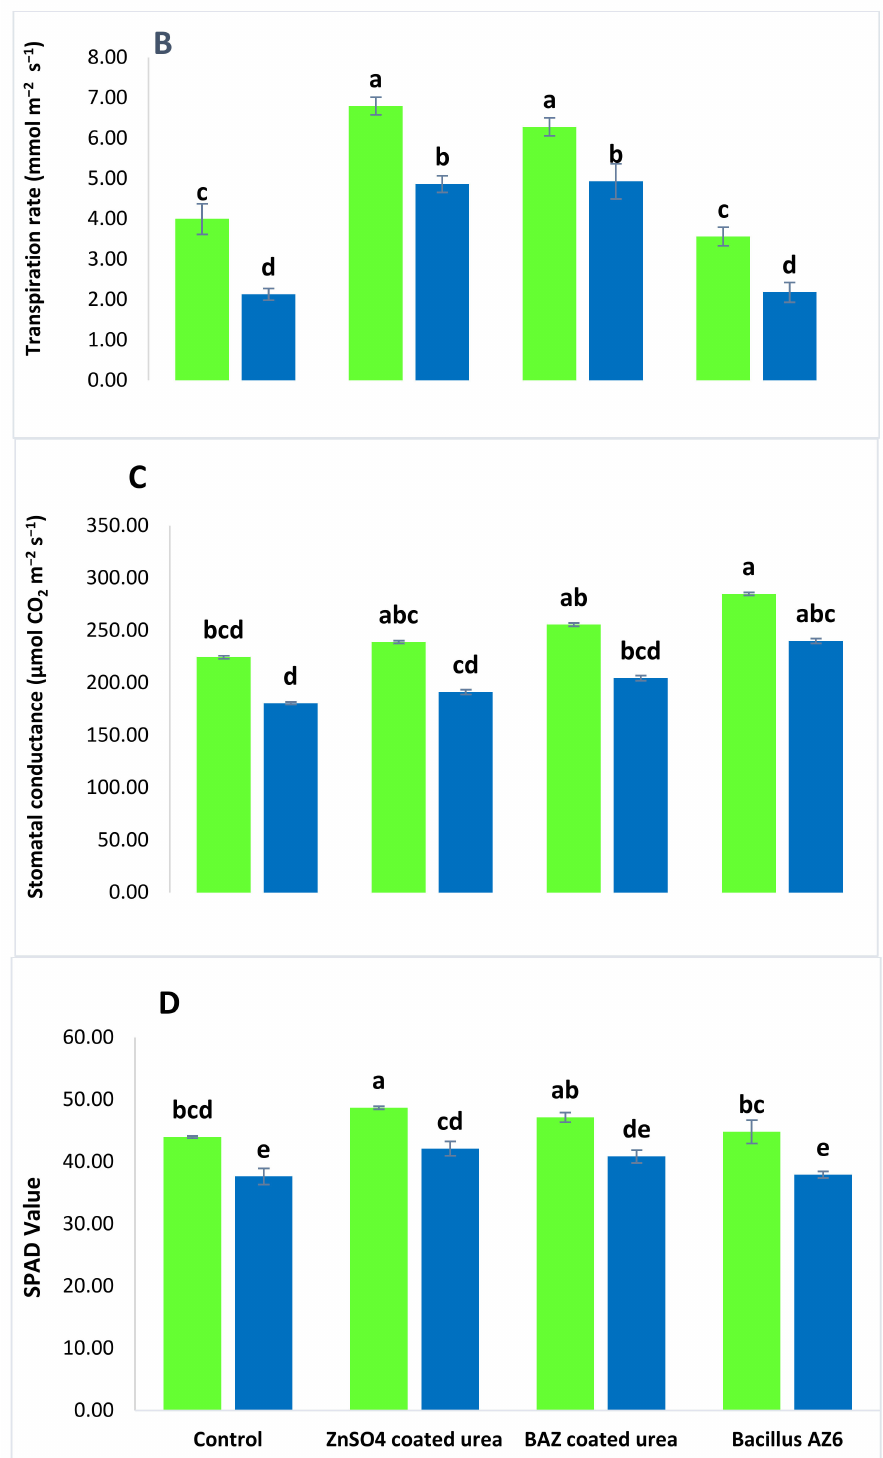
Figure 1. The photosynthetic rate ( A ), transpiration rate ( B ), stomatal conductance ( C ), and soil plant analysis development (SPAD) value ( D ) of wheat grown with BAZ ( Bacillus augmented ZnO)-coated urea under salinity stress. These physiological attributes were observed at the flowering stage, and the data presented here are the means of three replications ( n = 3) ± standard error, having three plants in each replication. Di ff erent alphabetical letters above error bars show significant di ff erences ( p ≤ 0.05) among di ff erent